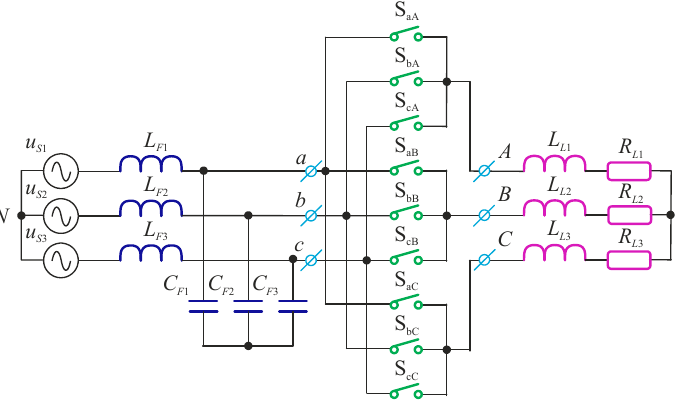
Figure 1. Matrix converter schematic diagram.